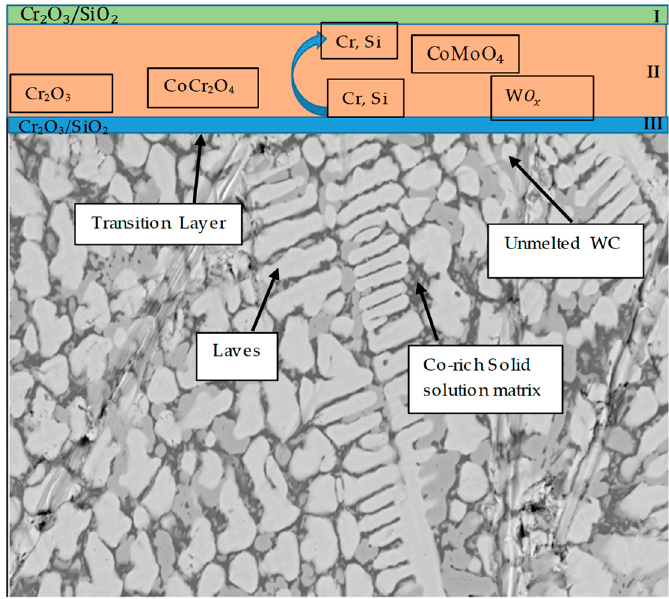
Figure 12. The oxidation mechanism of the LCAP T-800/WC coating.